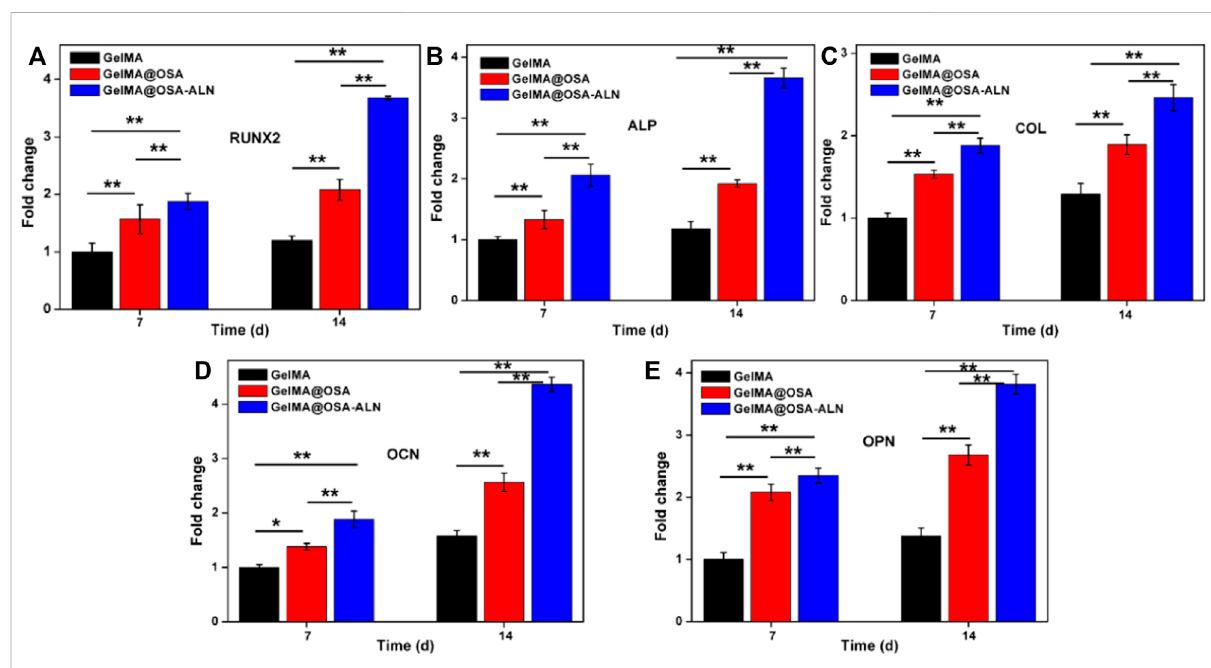
FIGURE 6 qRT-PCR analysis of mRNA levels of osteogenic genes. Relative gene expression of (A) Runx 2, (B) ALP, (C) COL, (D) OCN and (E) OPN on day 7 and 14 of culture. Statistically signi fi cant differences of GelMA, GelMA@OSA and GelMA@OSA-ALN ( p p < 0.05, pp p <